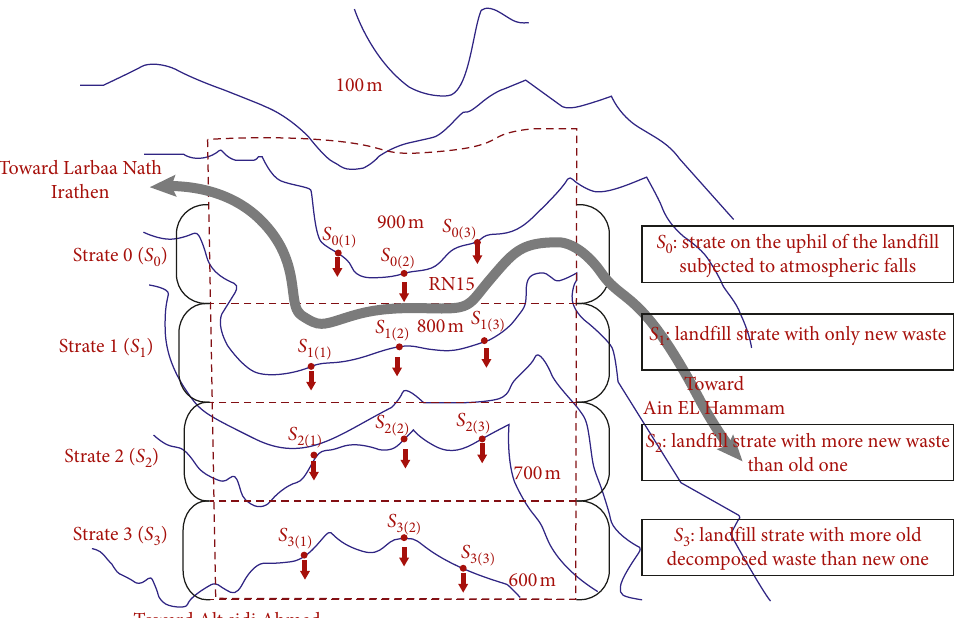
Figure 1: Random stratified sampling in the A.E.H. landfill soil (scale: